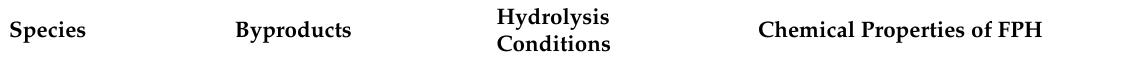
Table 1. Enzymatic hydrolysis and chemical properties of FPH from seafood